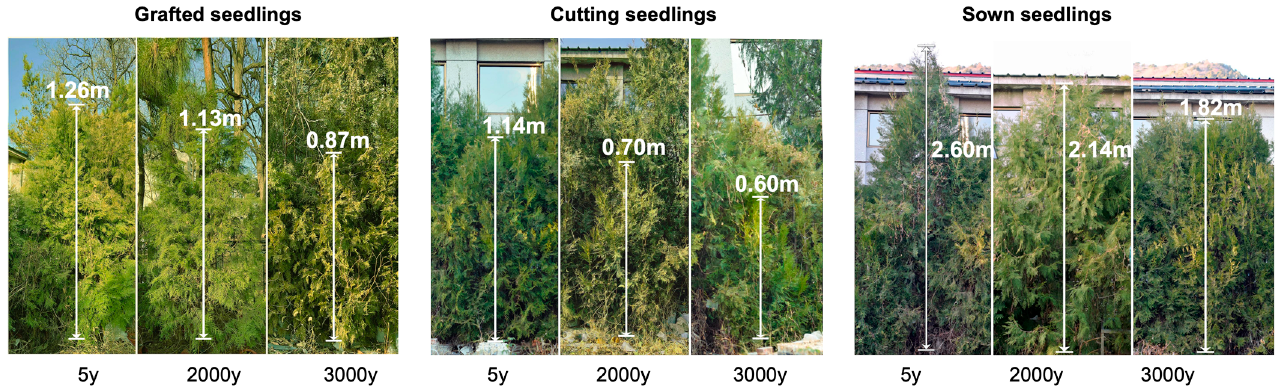
Figure 1. Sample trees were 5-year-old uniform seedlings of P. orientalis propagated from donors at different ages (5-, 2000-, and 3000-year-old) in different methods (seed sowing, cutting, and grafting), respectively.